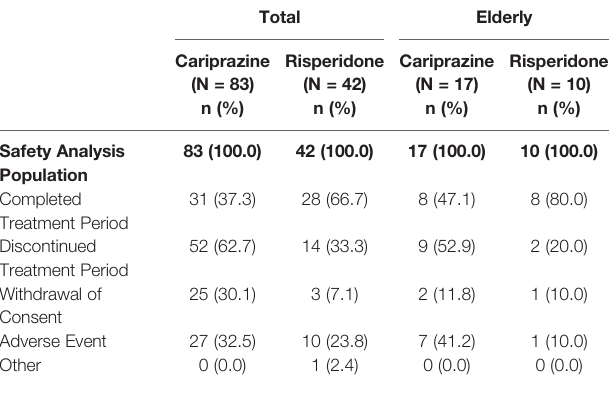
TABLE 4 | Patient disposition (Safety Analysis Population,